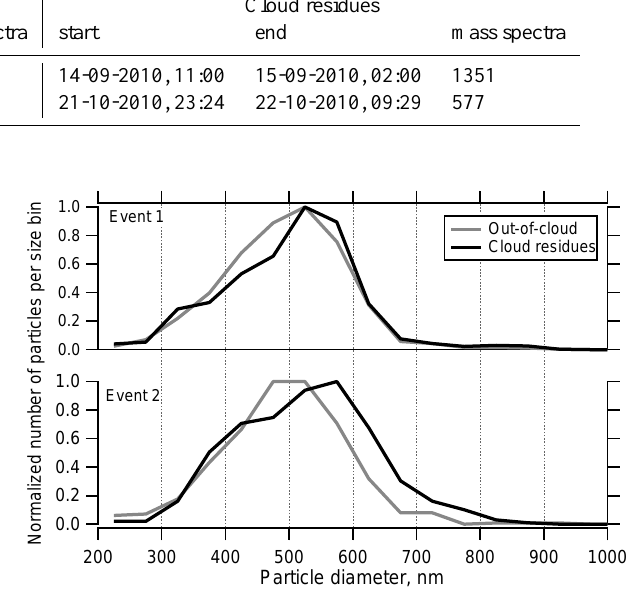
Figure 12. Histograms of particles analysed by ALABAMA dur- ing event I and event II (Table 5). In both cases the histograms are shifted to larger sizes for the cloud residues, indicating the uptake of gaseous compounds by the cloud droplets leading to an increased size of the cloud residual particles compared to the out-of-cloud par- ticles measured shortly before cloud